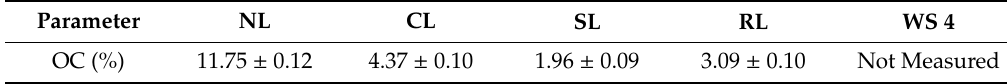
Table 3. Organic carbon (OC) in the